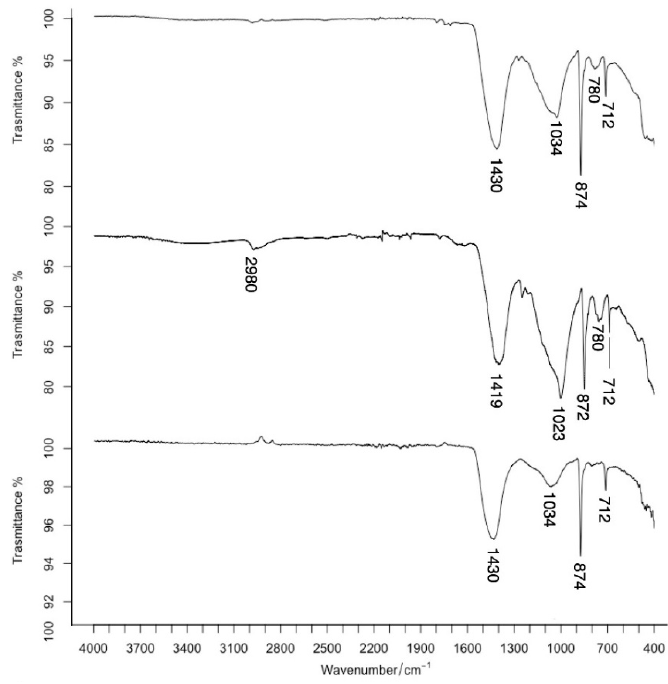
Figure 9. FT-IR spectra of samples 1, 15 and 23 (from top to bottom).